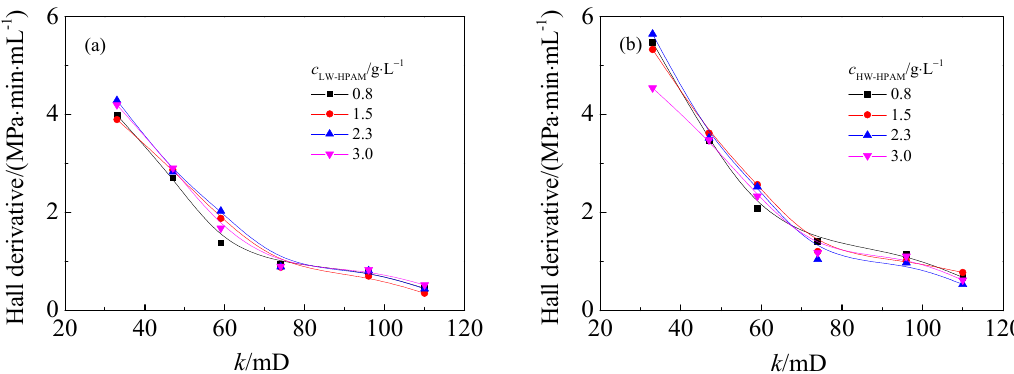
Figure 13. Variation of the Hall derivative of ( a ) LW-HPAM and ( b ) LW-HPAM with core permeability at different concentrations.